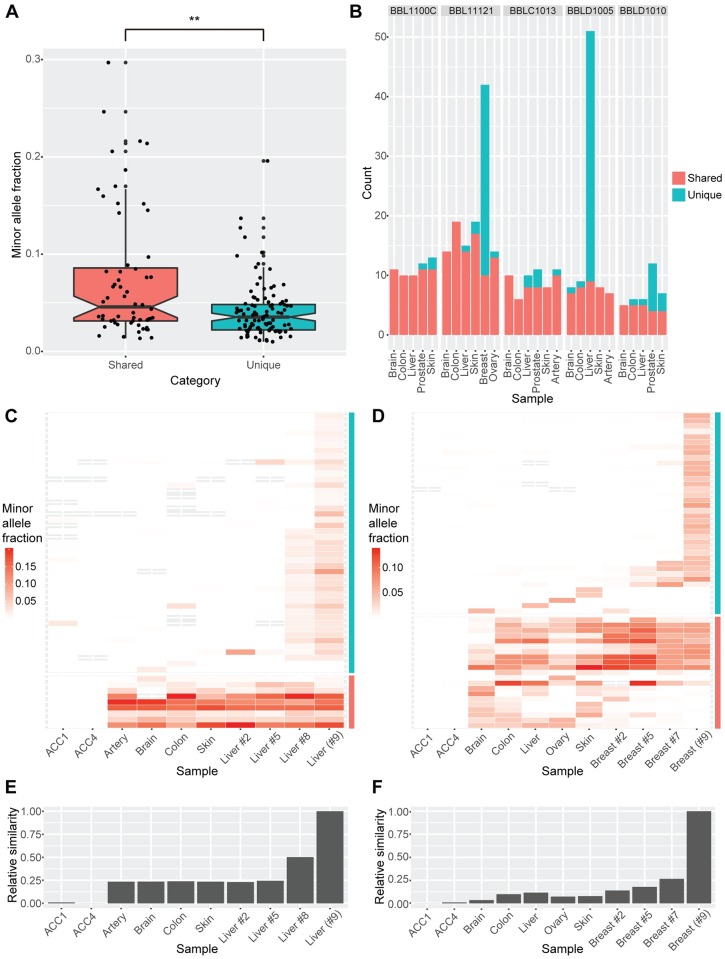
Two types of pSNMs revealed by inter- and intra-organ profiles.(A) Minor allele fractions between different categories of pSNM. The organ-shared pSNMs demonstrated significantly higher allele fractions than the organ-unique pSNMs. (B) Number of pSNMs carried in different organ samples. Red and blue bars denote the organ-shared and organ-unique pSNMs, respectively. An excess of organ-unique pSNMs was observed in the breast sample of BBL11121 and the liver sample of BBLD1005. (C-D) Heatmap of minor allele fractions for pSNMs carried in multiple organ samples of BBLD1005 (C) and BBL11121 (D). Blood samples of two unrelated individuals (ACC1 and ACC4) served as negative controls. The color intensity of each tile represents allele fractions estimated by targeted ultra-depth resequencing. Gray tiles denote sites without sufficient read depth (< 30X). Red and blue bars denote the organ-shared and organ-unique pSNMs, respectively. The majority of organ-unique pSNMs were locally restricted to one or a few physically adjacent organ samples (<1 cm). (E-F) Relative intra-organ similarity of pSNM profiles in BBLD1005 (E) and BBL11121 (F). The originally sequenced samples (liver #9 and breast #9) shared the largest similarity to their physically closest samples.